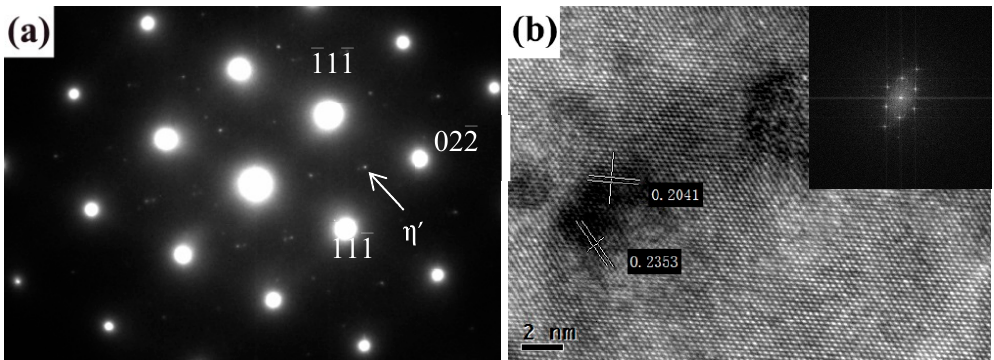
Figure 13. TEM images of welded joints after PWHT with solution at 490 °C for 80 min followed by aging at 120 °C for 24 h: ( a ) SAED image and ( b ) HRTEM image.